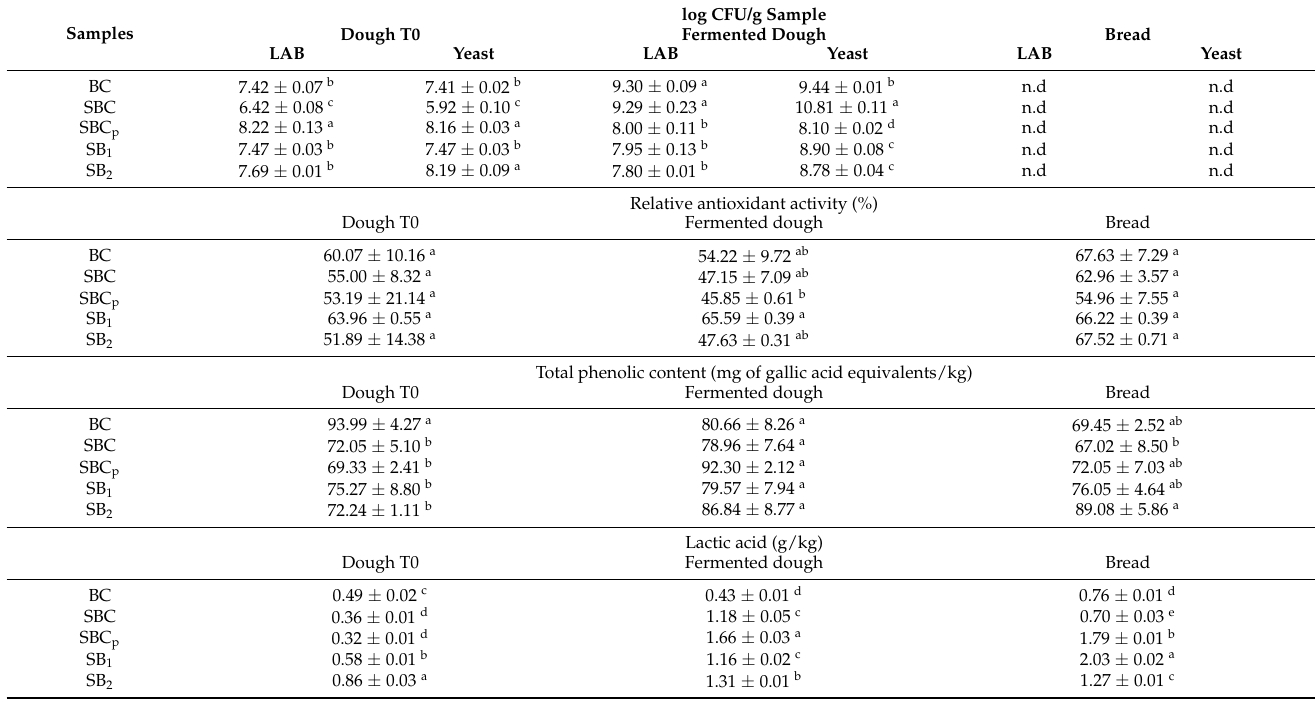
Table 4. Results of microbiological analysis, antioxidant activity, total phenolic content, and organic acids in doughs before fermentation (T0), after dough fermentation, and after baked